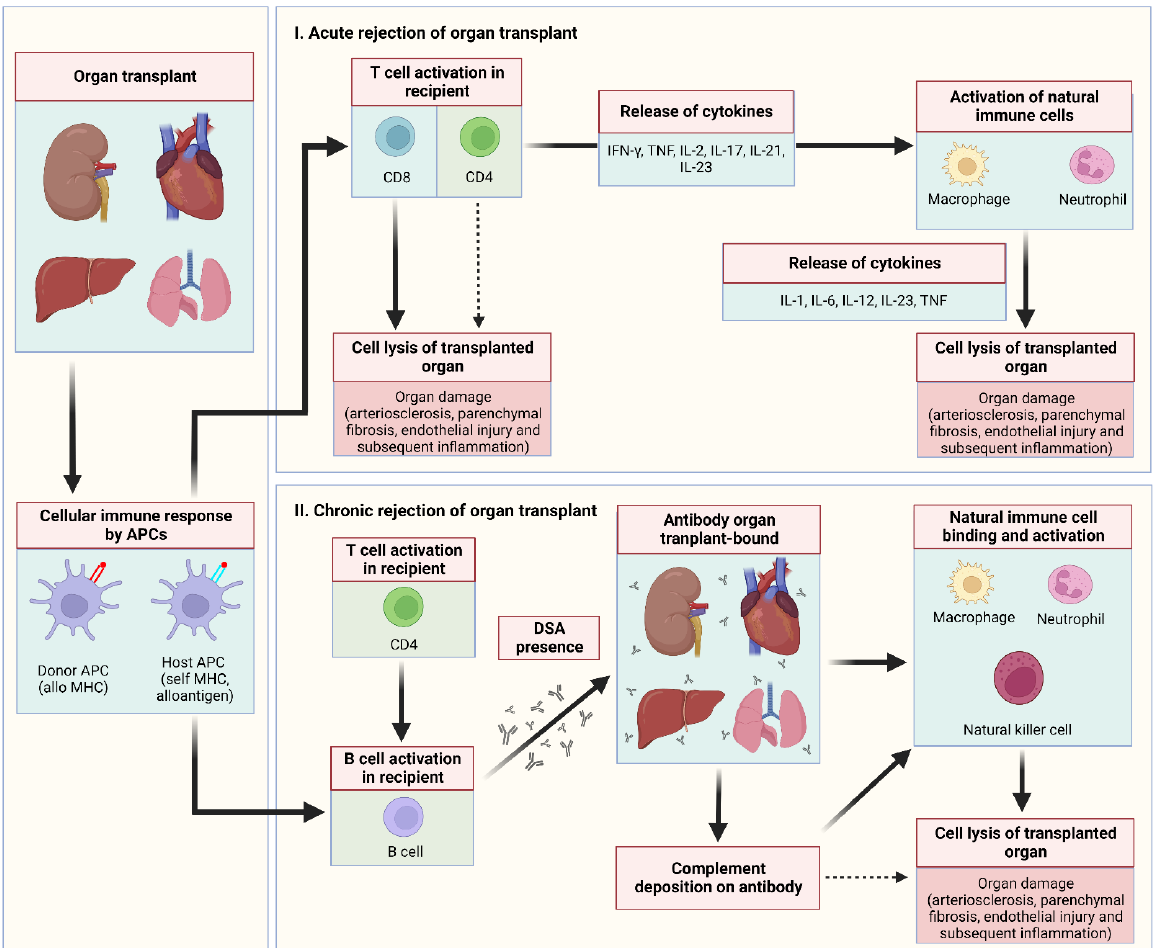
Figure 1. Schematic representation of intracellular signalling in solid organ rejection. In general, once T cell activation occurs, a chain of intracellular events is triggered under the influence of growth and differentiation factors. In acute rejection of organ transplant, recipient CD8 T cells and, to a lesser extent, CD4 T cells directly destroy the organ transplant. Moreover, CD4 cells in the recipient cause organ damage via the secretion of extraordinary array of cytokines with a bewildering number of functions that activate the host’s natural immune system (macrophages and neutrophils). In chronic rejection of organ transplant, donor-specific antibodies are released that bind to the organ transplant to instigate the host’s natural immune system (macrophages, neutrophils and natural killer cells) and cause complement deposition. Abbreviations: APCs, antigen-presenting cells; DSA, donor-specific antibodies; IL-1, interleukin-1; IL-2, interleukin-2; IL-6, interleukin-6; IL-12, interleukin-12; IL-17, interleukin-17; IL-21, interleukin-21; IL-23, interleukin-23; IFN- γ , interferon gamma; MHC, major histocompatibility complex; TNF, tumour necrosis